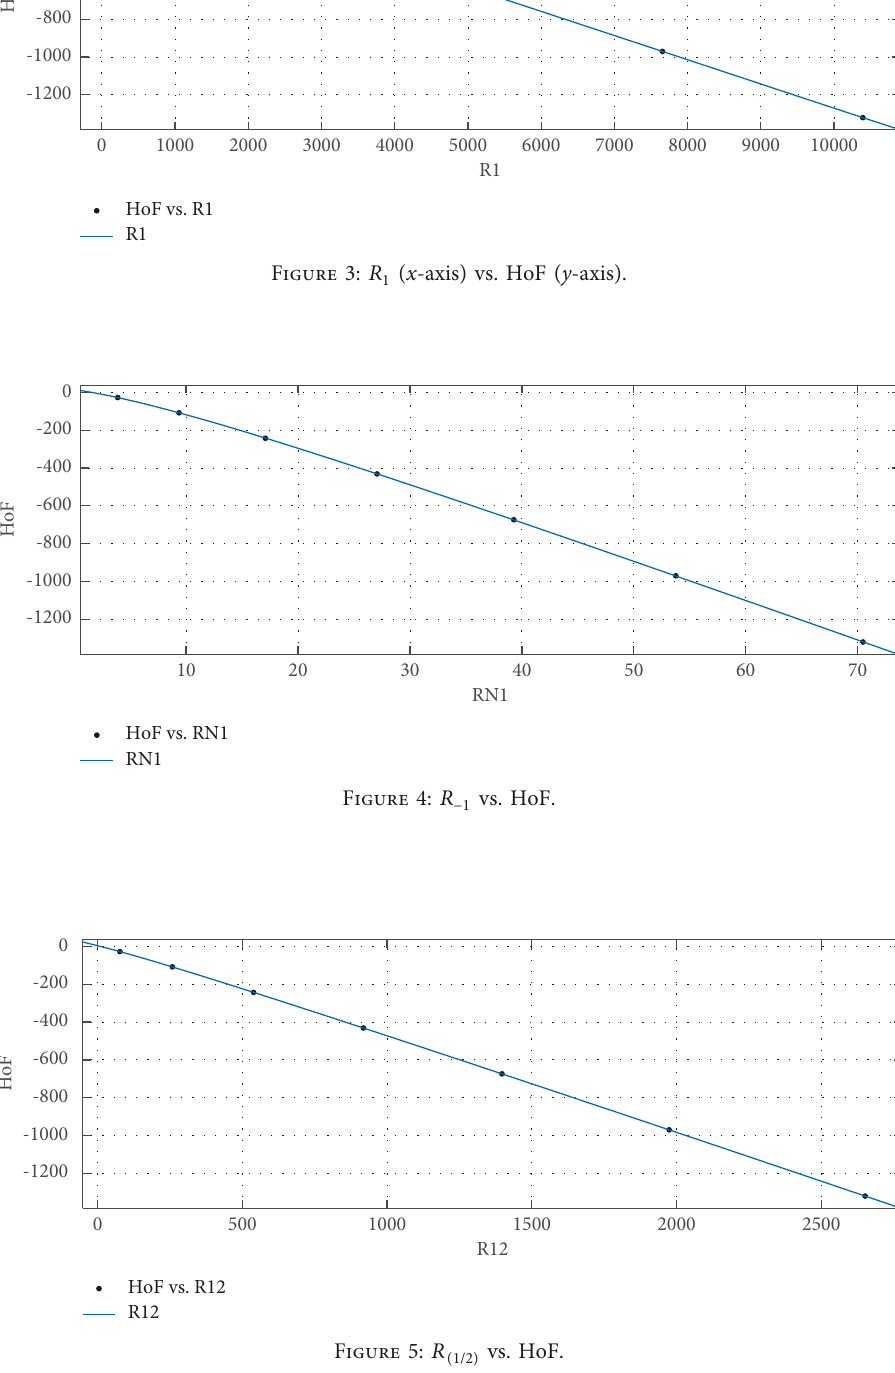
2.1. Thermodynamical Properties (HoF and Entropy) of Ni- obium (II) Oxide. Many topological indices are derived for unit cell of NbO, including M ; M ; ABC; GA; and AZI. 1 1